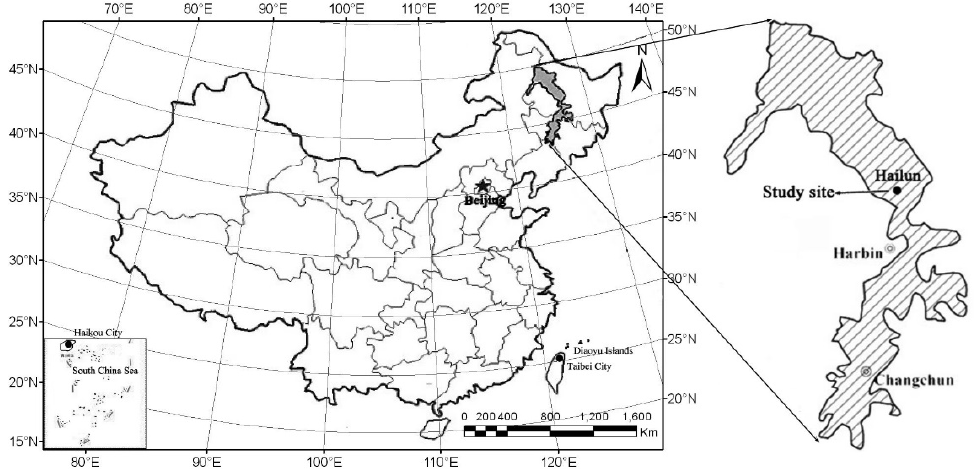
Figure 1. The study area with different scales in a map of China.